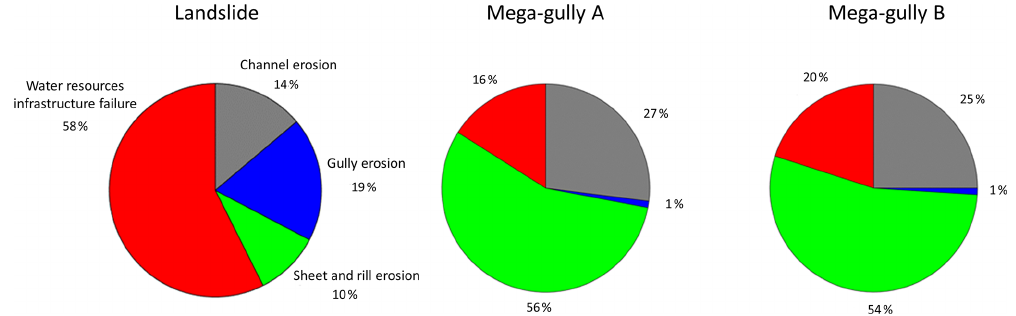
Figure 6. Relative contribution of sheet and rill erosion, gully erosion, channel erosion, and water resources infrastructure failure (WRIF) towards sediment generation for three storm events with WRIF.